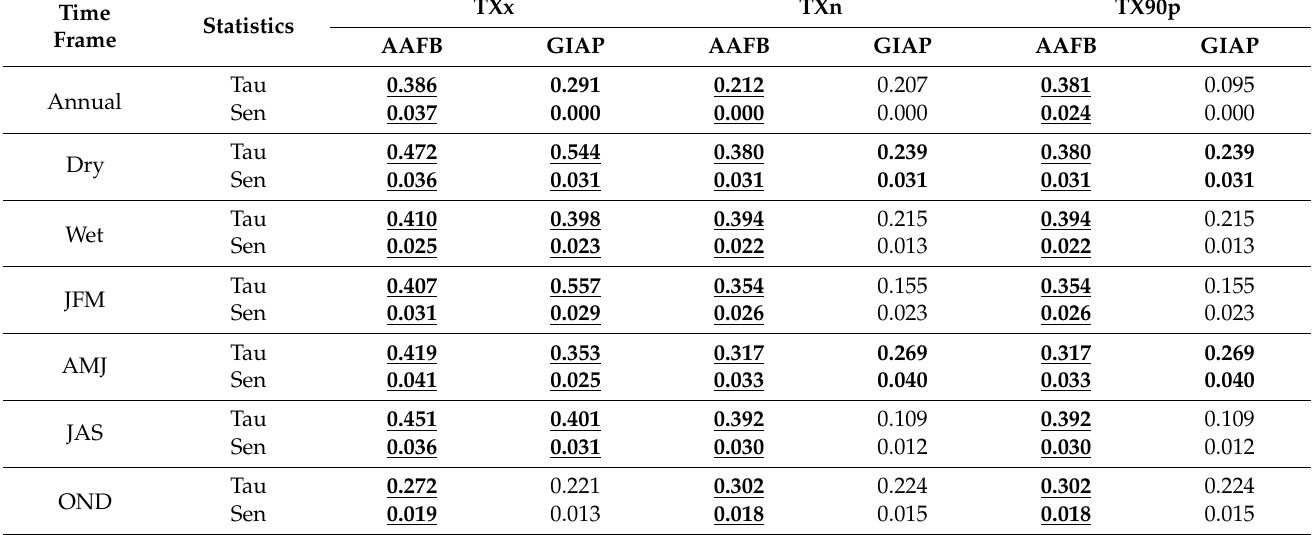
Table 3. Mann–Kendall’s tau and Sen’s slope ( ◦ C/year) for annual/two-seasonal/four-seasonal maximum of Tmax, minimum of Tmax, and the 90th percentile of Tmax from two stations (Andersen Airforce Base and Guam International Airport). Bold and underlined values represent statistically significant strong trend ( p ≤ 0.05), and those bold represent a significant trend (0.05 < p -value ≤ 0.1). Here, JFM denotes the season from January to March, AMJ does from April to June, JAS does